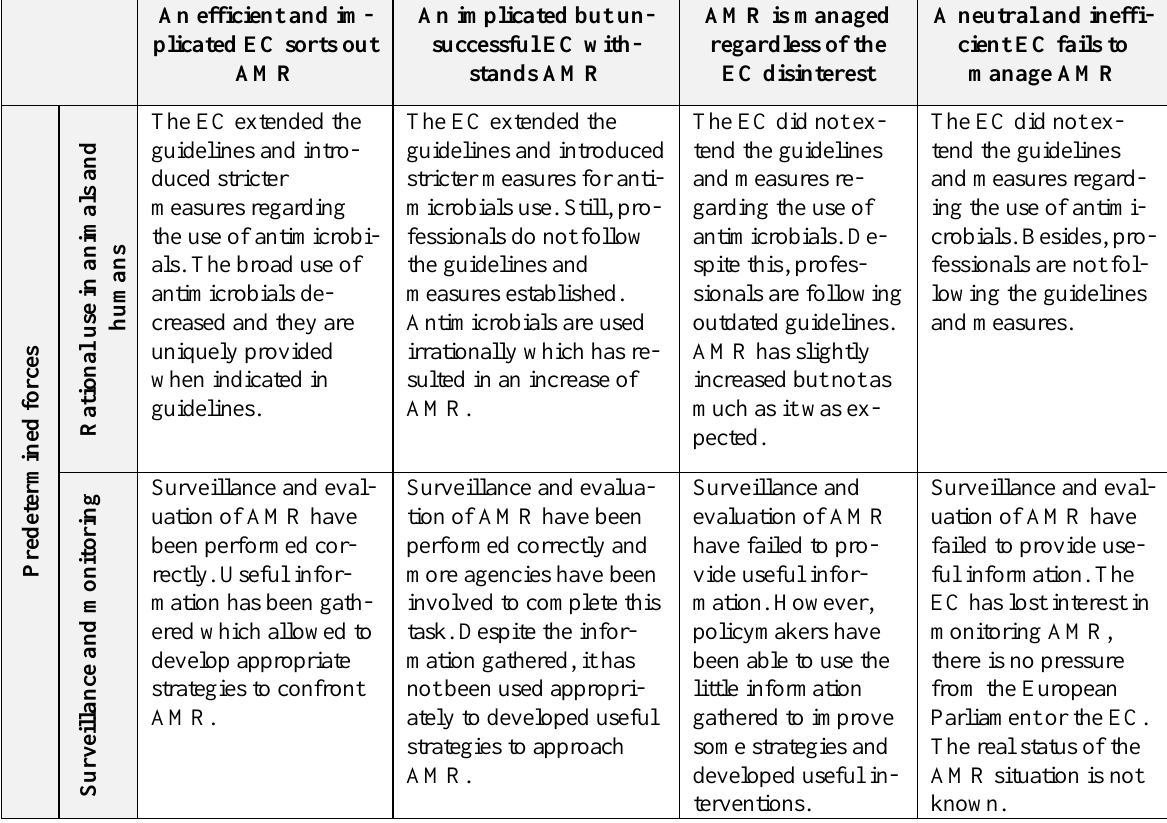
Table 1. Scenario planning for AMR in view of the EC